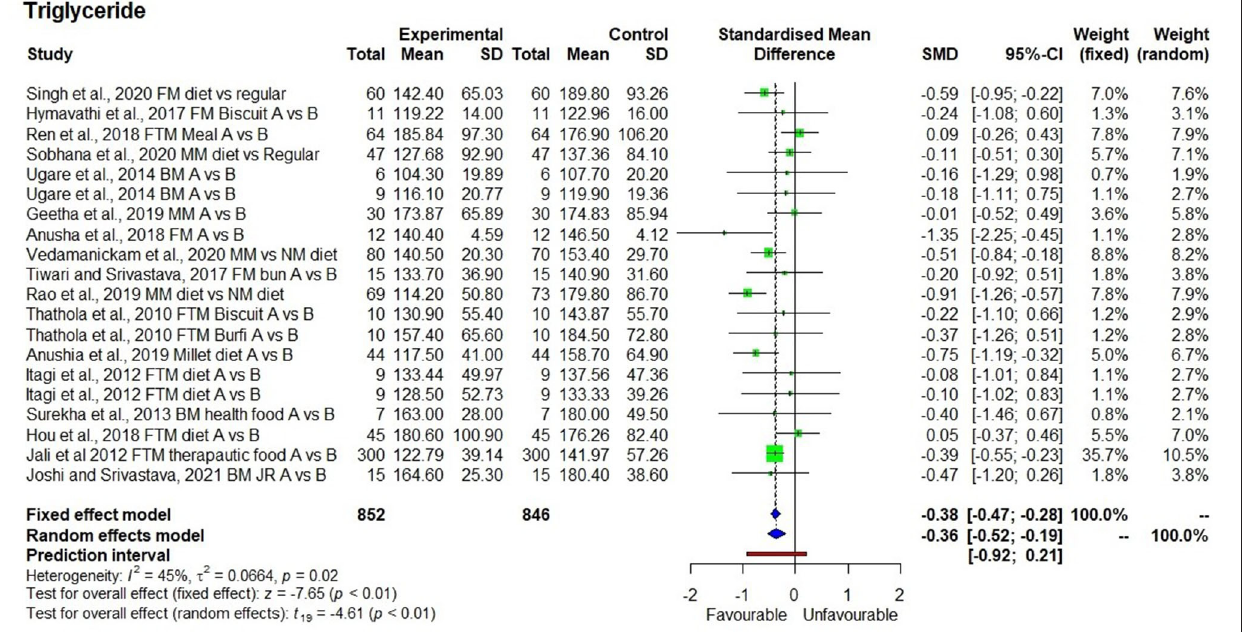
The meta-analysis conducted on an outcomes-generated forest plot shows a significant reducing effect in TC levels after the consumption of a millet-based diet for 21 days to 4 months ( p = 0.01) with SMD of − 0.56, 95% class interval of − 0.94